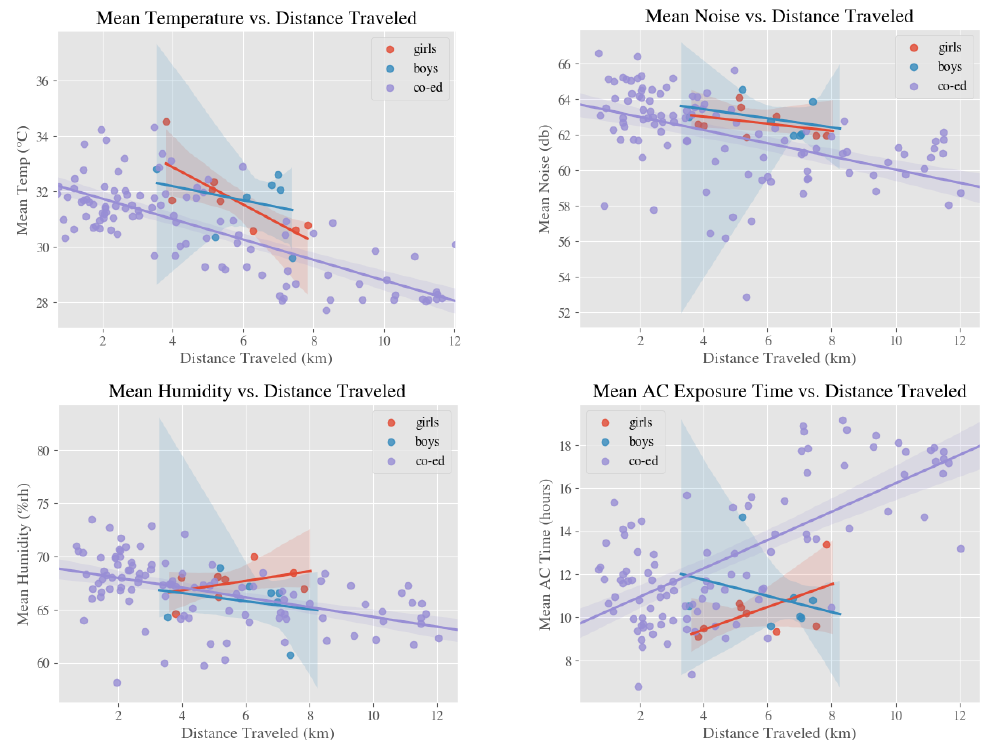
Figure 2. Relationships between environmental exposures and distance traveled between home and school with respect to the gender of the school student